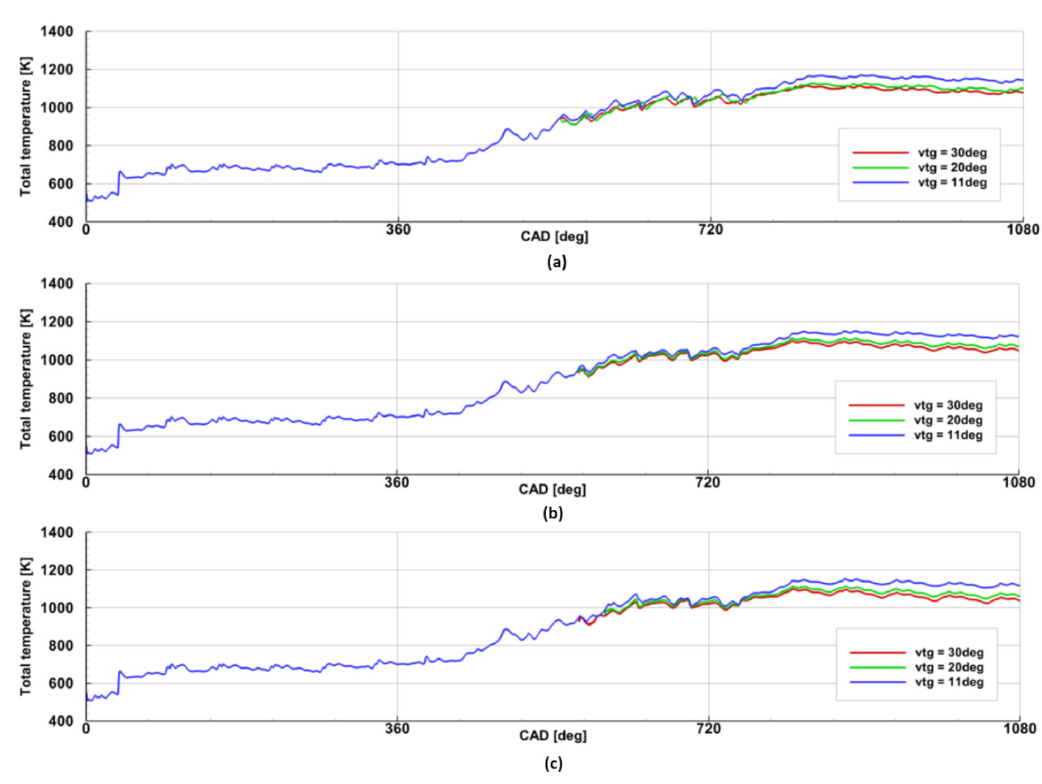
Figure 19. The outlet total temperature variation at the 1st stage rotor at the three different VTG openings for: ( a ) 60,000 rpm, ( b ) 50,000 rpm, ( c ) 40,000